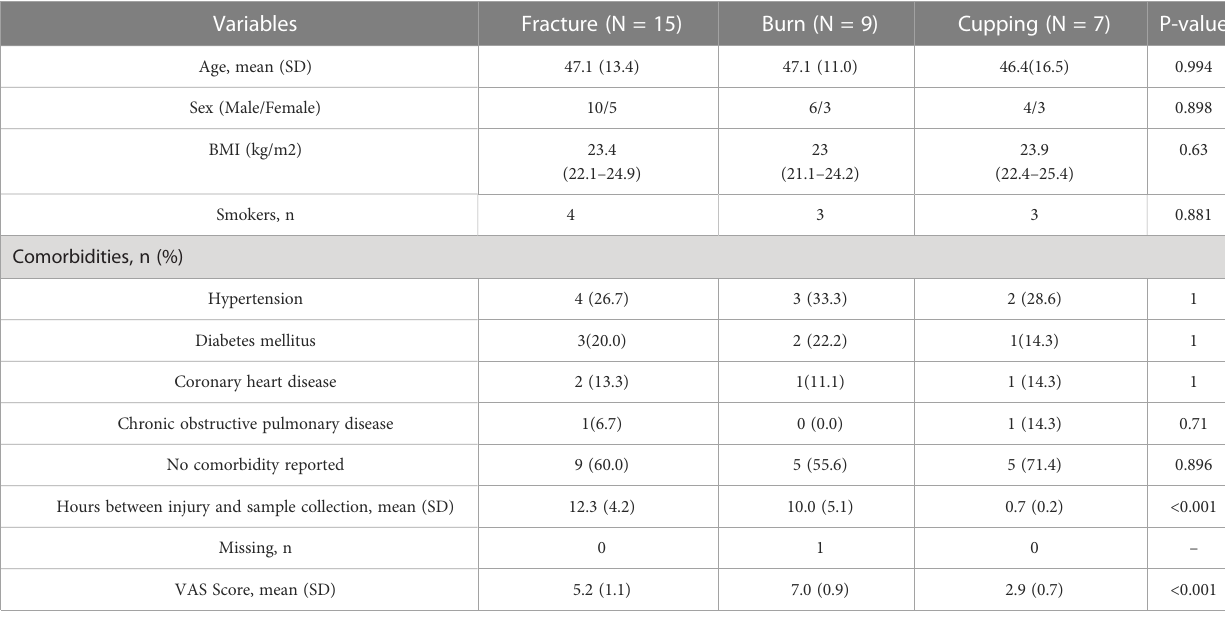
TABLE 1 Patient characteristics.